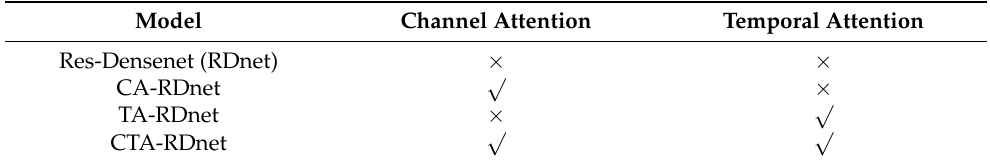
Table 5. Four models for the ablation experiment. Model Channel Attention Temporal Attention